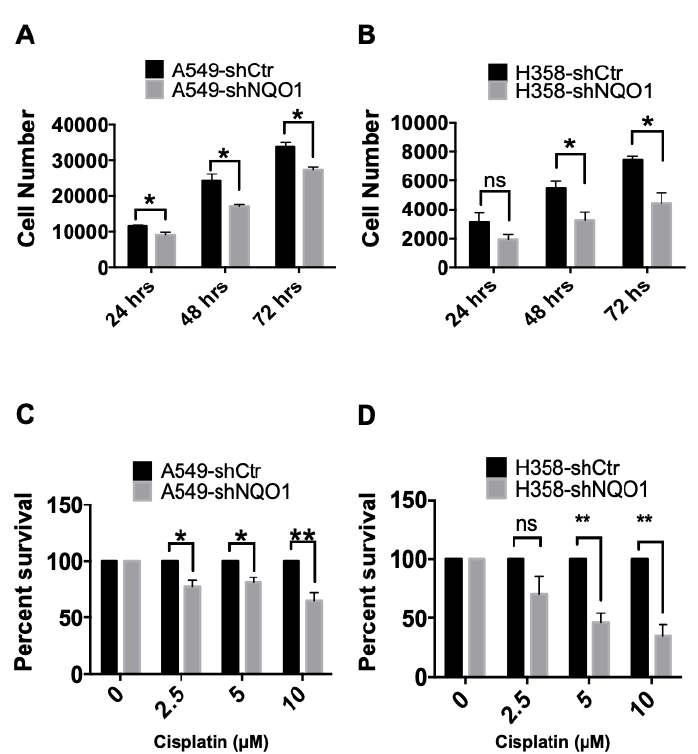
Figure 6. NQO1 depletion increases sensitization to cisplatin treatment and inhibits spheroid-cultured cell proliferation. In ( A ), A549-shCtr and A549-shNQO1 primary spheroids were dissociated,